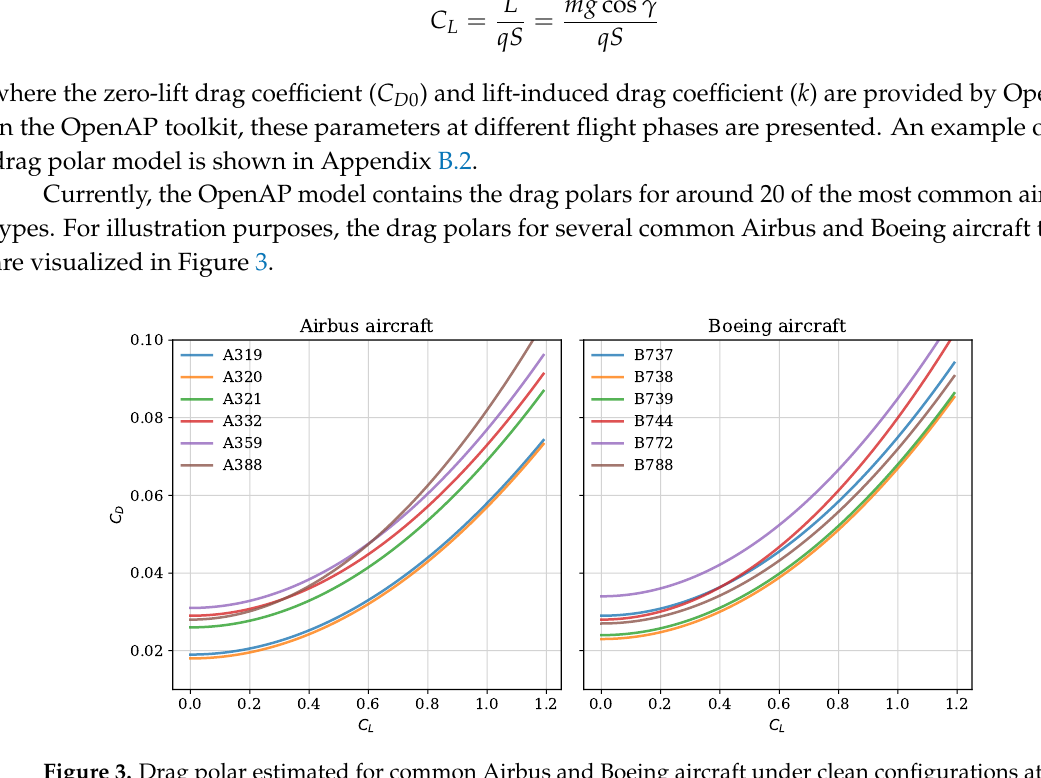
Figure 3. Drag polar estimated for common Airbus and Boeing aircraft under clean configurations at low Mach